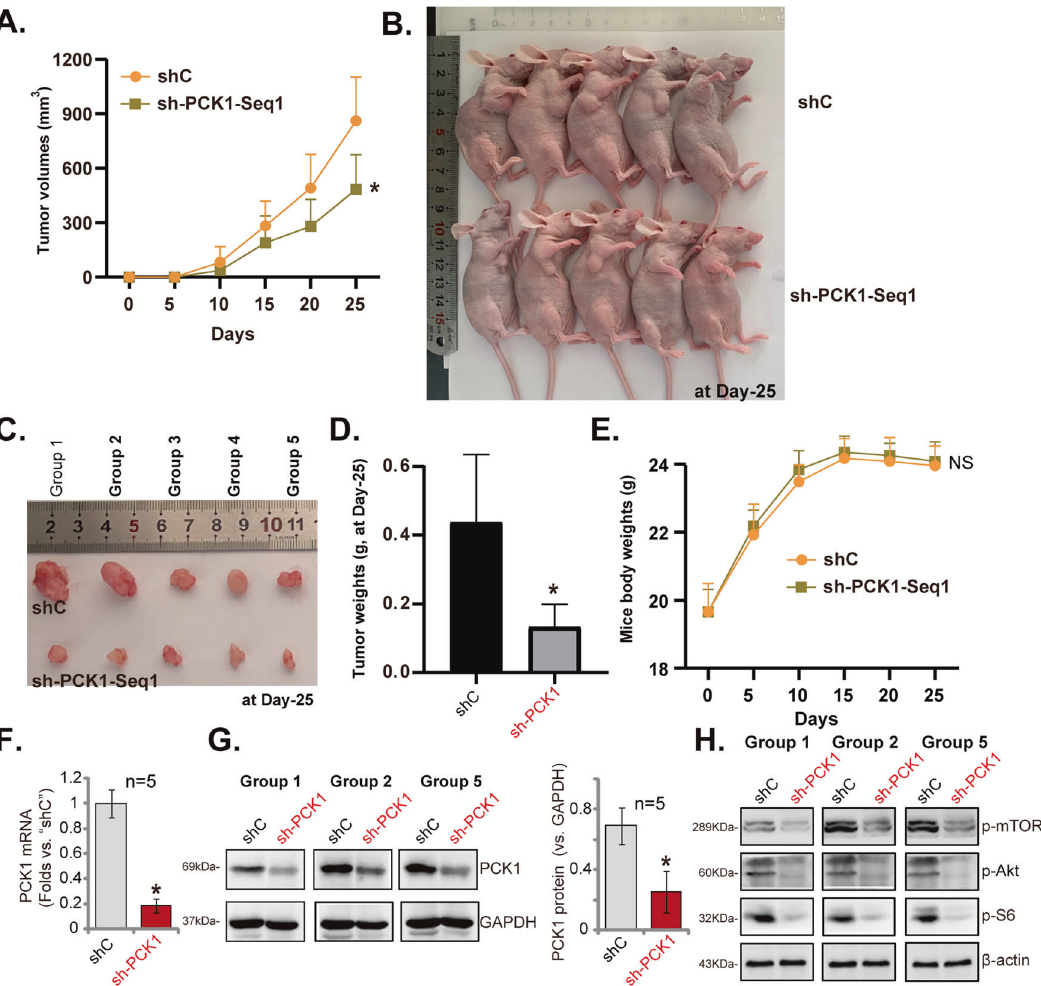
Fig. 7 PCK1 silencing suppresses pancreatic cancer xenograft growth in mice. PANC-1 xenografts-bearing female BALB/c nude mice were established by subcutaneous injection of PANC-1 cells expressing PCK1 shRNA ( “ sh-PCK1-seq1 ” ) or scramble control shRNA lentivirus ( “ shC ”